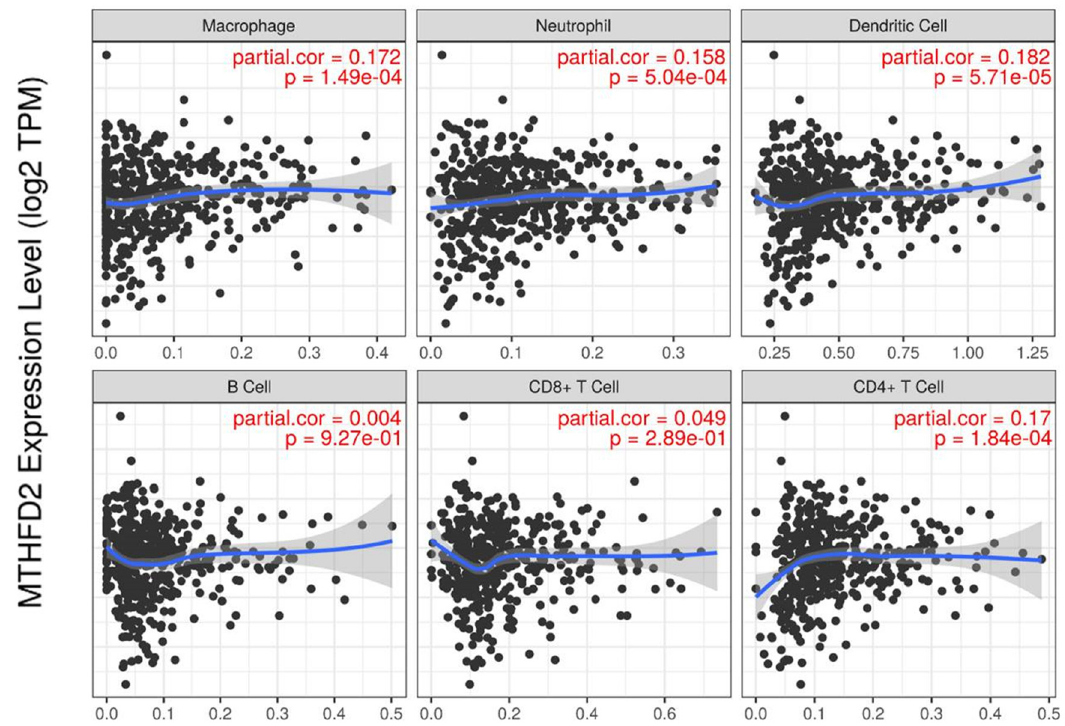
Figure 5: Scatter plot between MTHFD2 expression and immune in fi